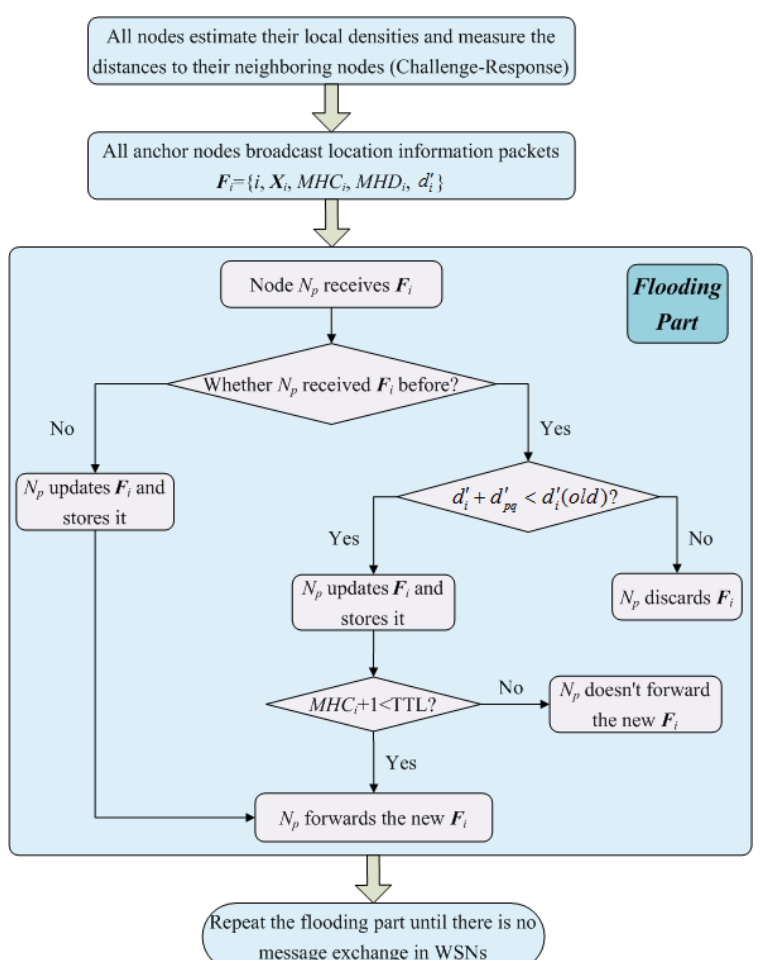
Figure 3. Network initialization